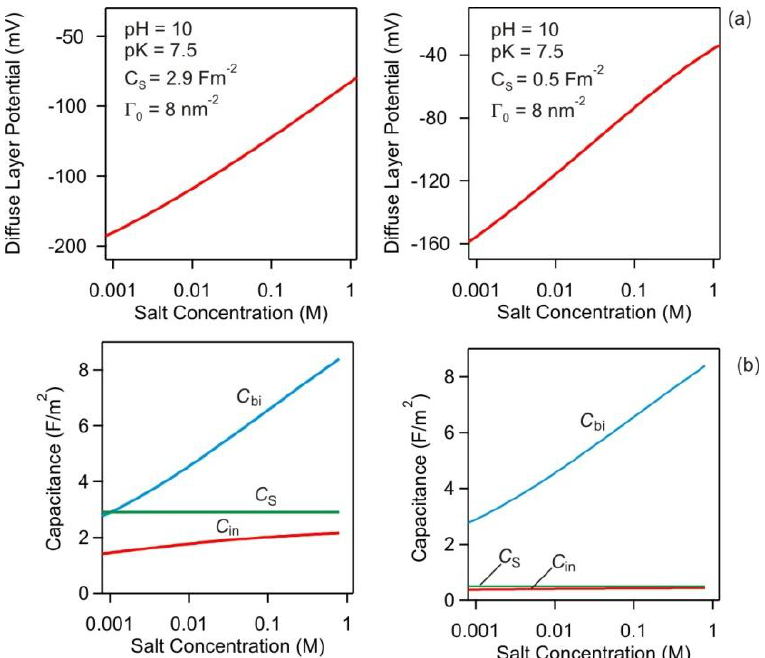
Figure 1. Predictions from the basic Stern model for ( a ) diffuse layer potential and ( b ) capacitances versus monovalent salt concentration. The parameters p K = 7.5, Γ 0 = 8 nm − 2 , and C S = 2.9 F/m 2 proposed by Hiemstra et al. [10], are used in the left column and in the right column the Stern capacitance is reduced to C S = 0.5 F/m 2 while other parameters are kept the same [14] .